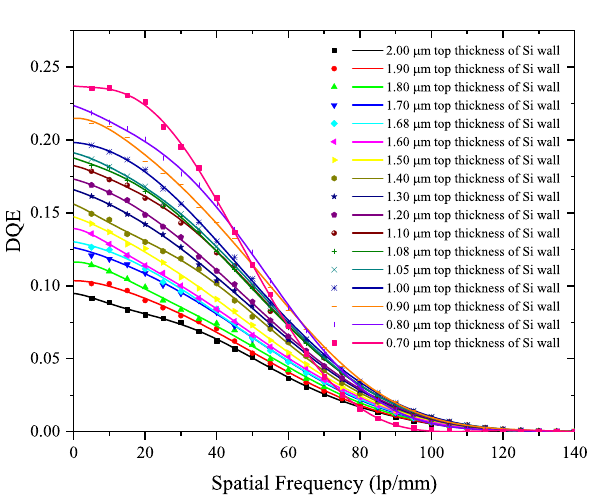
Figure 8. DQEs for the structured CsI(Tl) screens with different t Si